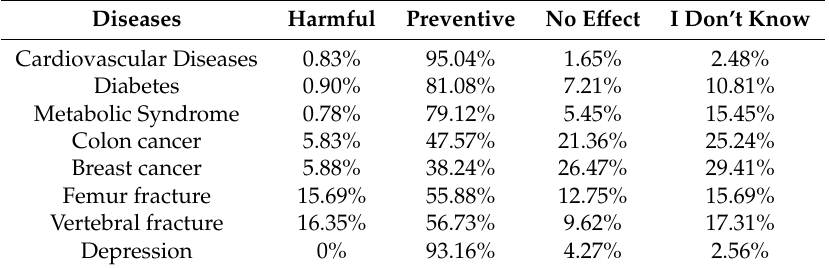
Table 3. Perceived e ff ects of PA on di ff erent